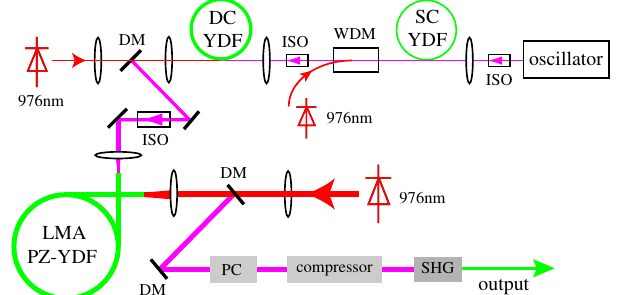
FIG. 8. Schematic of the 1300 MHz system: LMA, large mode area; PZ-YDF, single-polarization Yb-doped fiber; WDM, wave- length division multiplexer; SC, single clad; DC, double clad; ISO, optical isolator; DM, dichroic mirror; PC, Pockel ’ s cell; the compressor is a pair of gratings; SHG, second harmonic